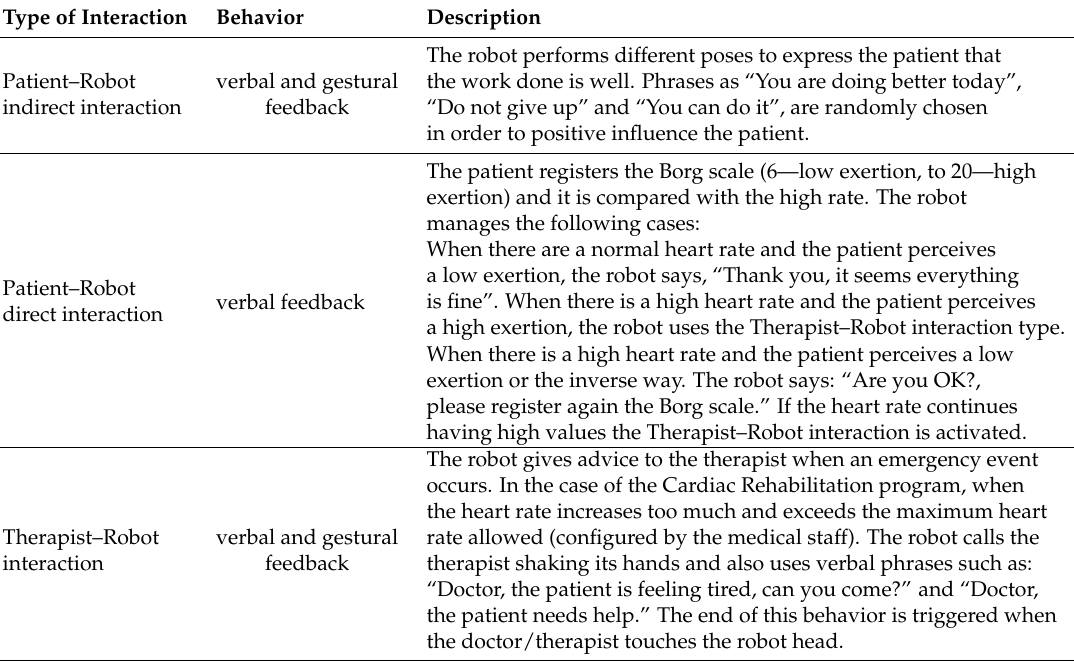
Table 2. Robot type of